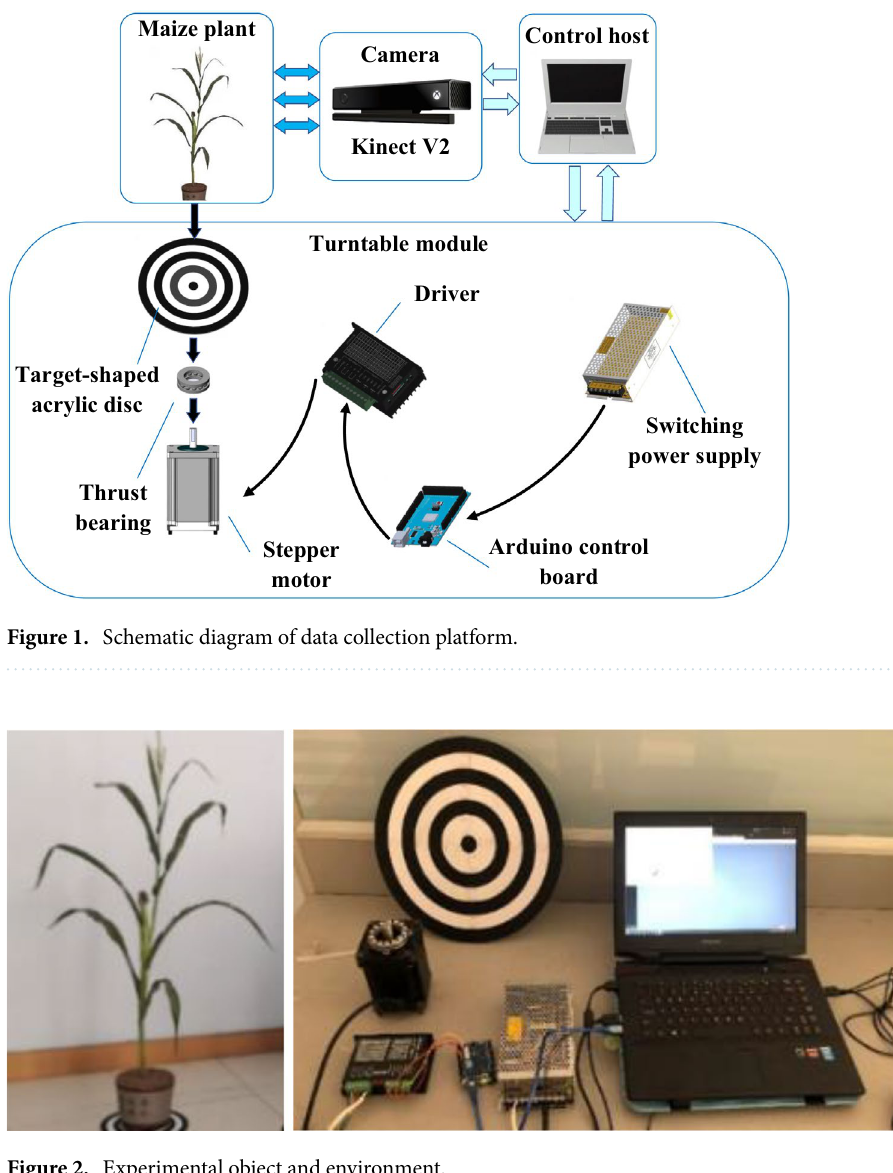
Figure 2. Experimental object and